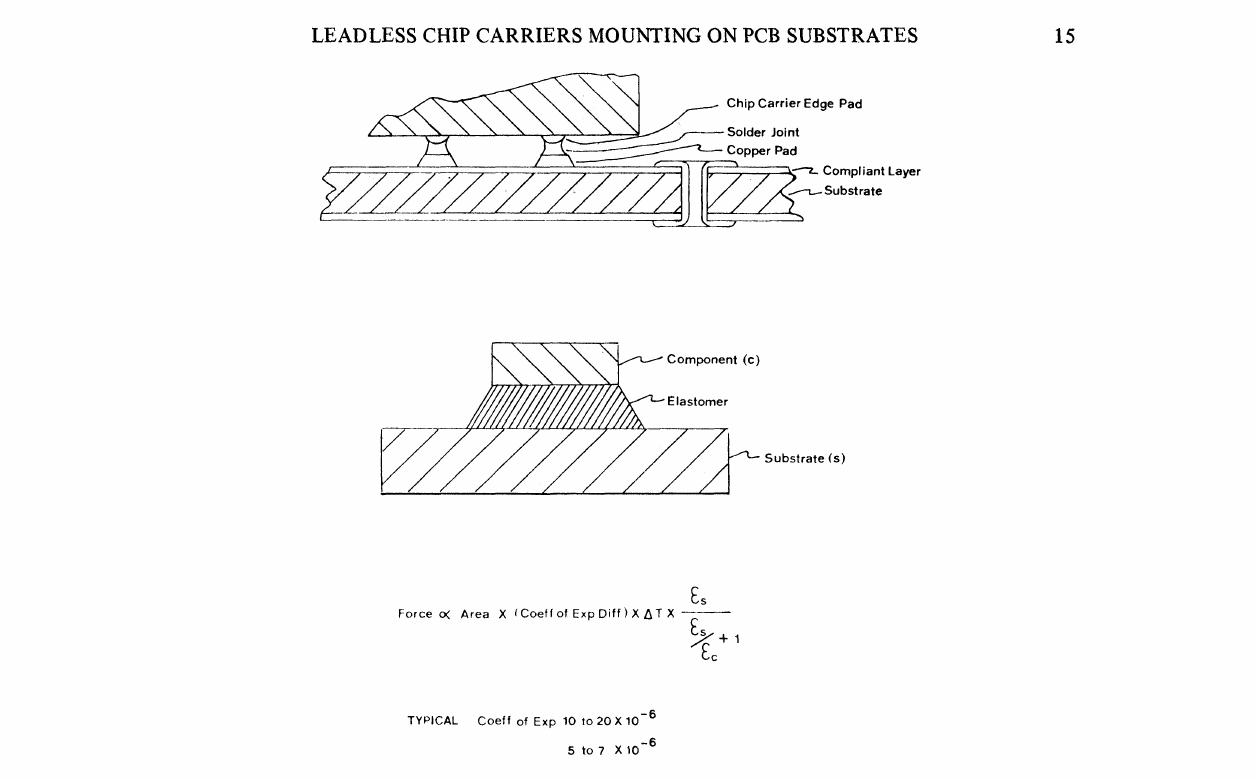
FIGURE 2 Attachment Systems and Stress Module for Joining Components to PCBs.